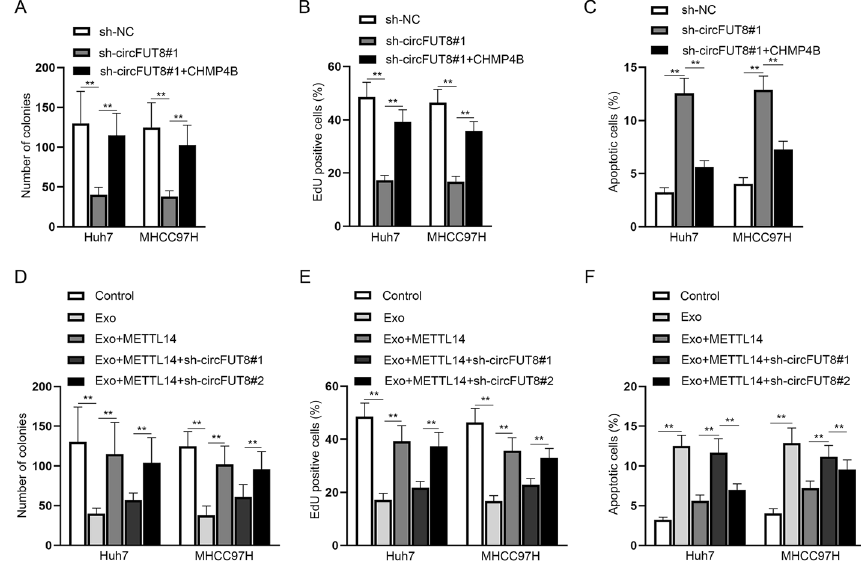
Fig. 7 M1-Exo regulated the circFUT8/CHMP4B axis via METTL14 to inhibit HCC cell progression. A – C The proliferation and apoptosis of HCC cells in different groups transfected with sh-NC, sh-circFUT8#1, and sh-circFUT8#1 CHMP4B plasmids was verified through colony formation together with EdU and flow + cytometry assays. D – F HCC malignant cell behaviors were evaluated through functional assays in different groups (control, Exo, Exo METTL14, Exo METTL14 sh-circFUT8#1, and Exo METTL14 sh-circFUT8#2). + + + + + In relevant assays, data in the experimental group was statistically significant in comparison with the negative control group ( P <